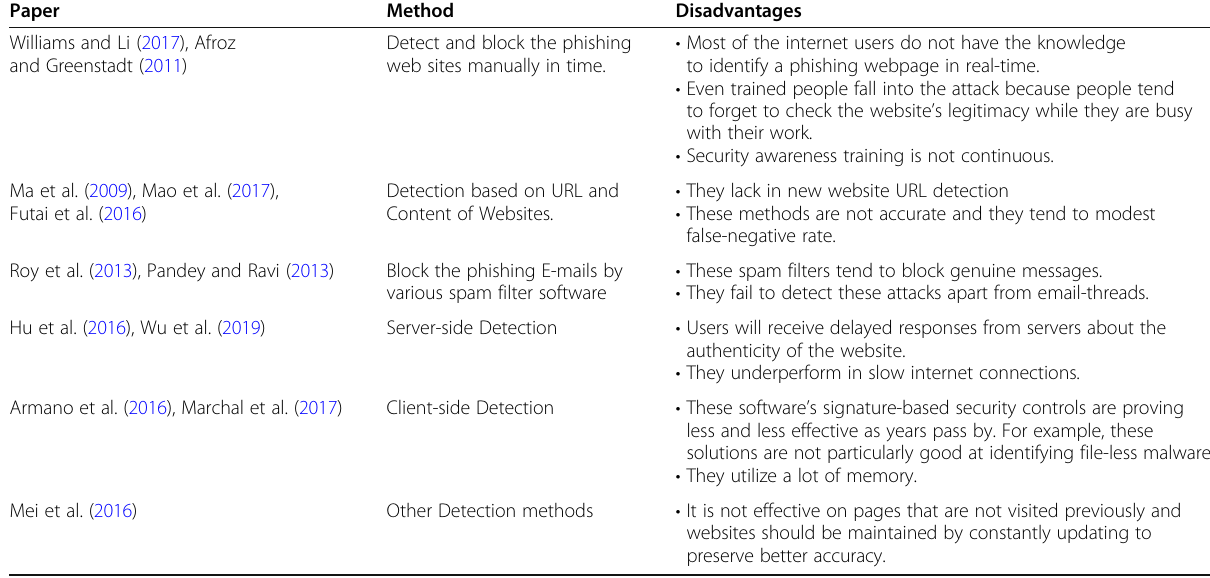
Table 1 Downsides of the existing phishing detection methods Paper Method